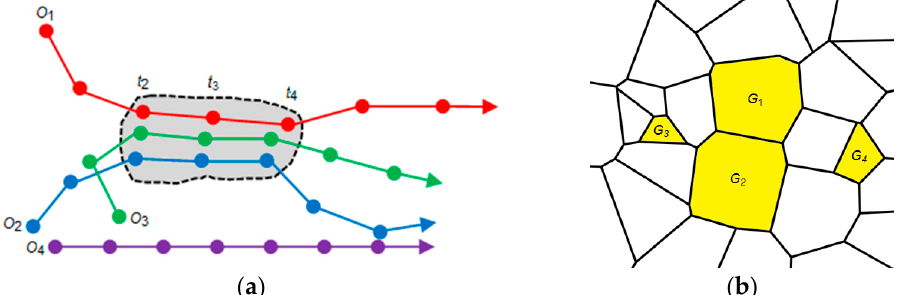
Figure 3. Illustration of flock and geographical flock: ( a ) a flock, and ( b ) a geographical flock.